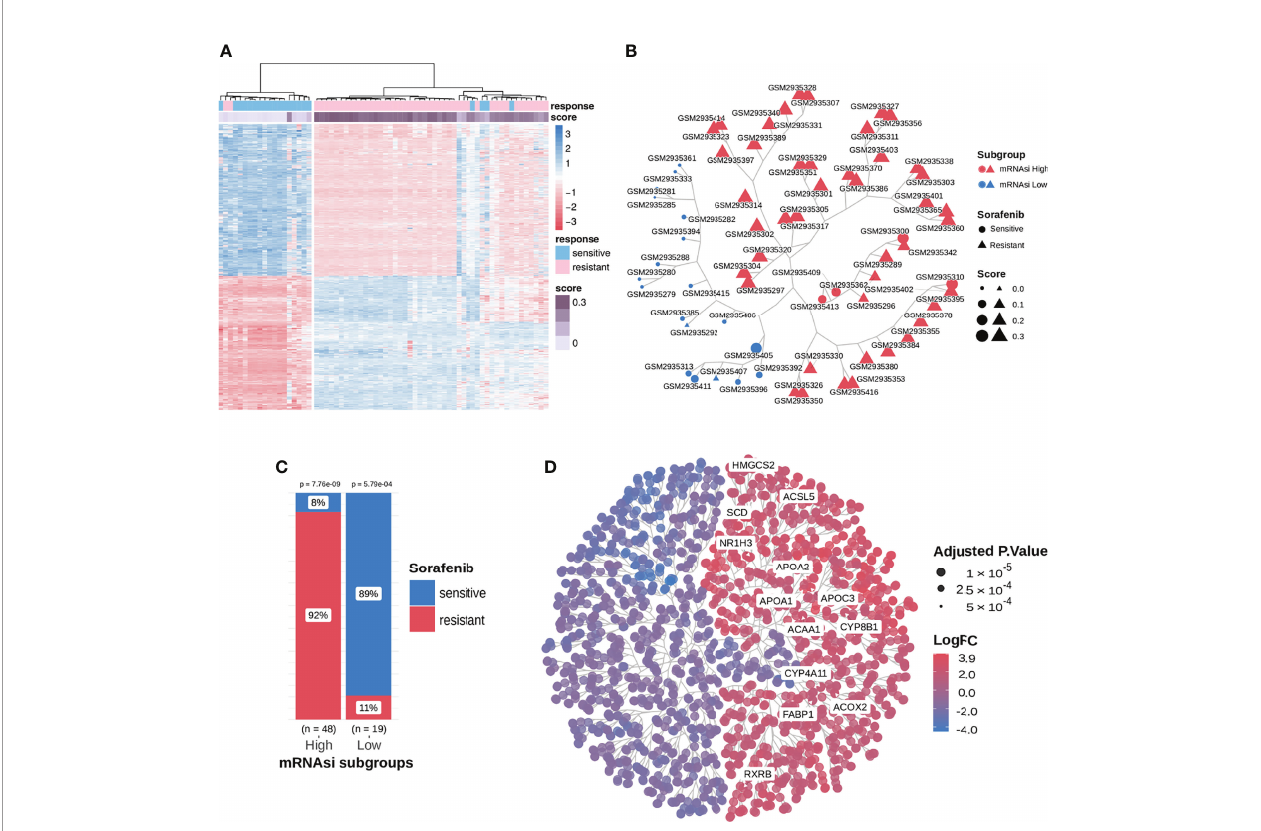
FIGURE 2 | Consensus clustering facilitated the identi fi cation of distinct mRNAsi-related clusters associated with different responses to sorafenib treatment; samples in the mRNAsi-high cluster were resistant to sorafenib and exhibited higher stemness proportions. (A) We extracted and compared 845 DEGs using subgroup classi fi cation in the sorafenib cohort GSE109211. (B) Tree-based visualization of the two mRNAsi subgroups. (C) The proportion of different responses to sorafenib (responder or non-responder) in the two mRNAsi subgroups with statistical signi fi cance. (D) Tree cluster of 1853 differentially expressed genes. Genes in the PPAR signaling pathway have been highlighted. See also Figure S1